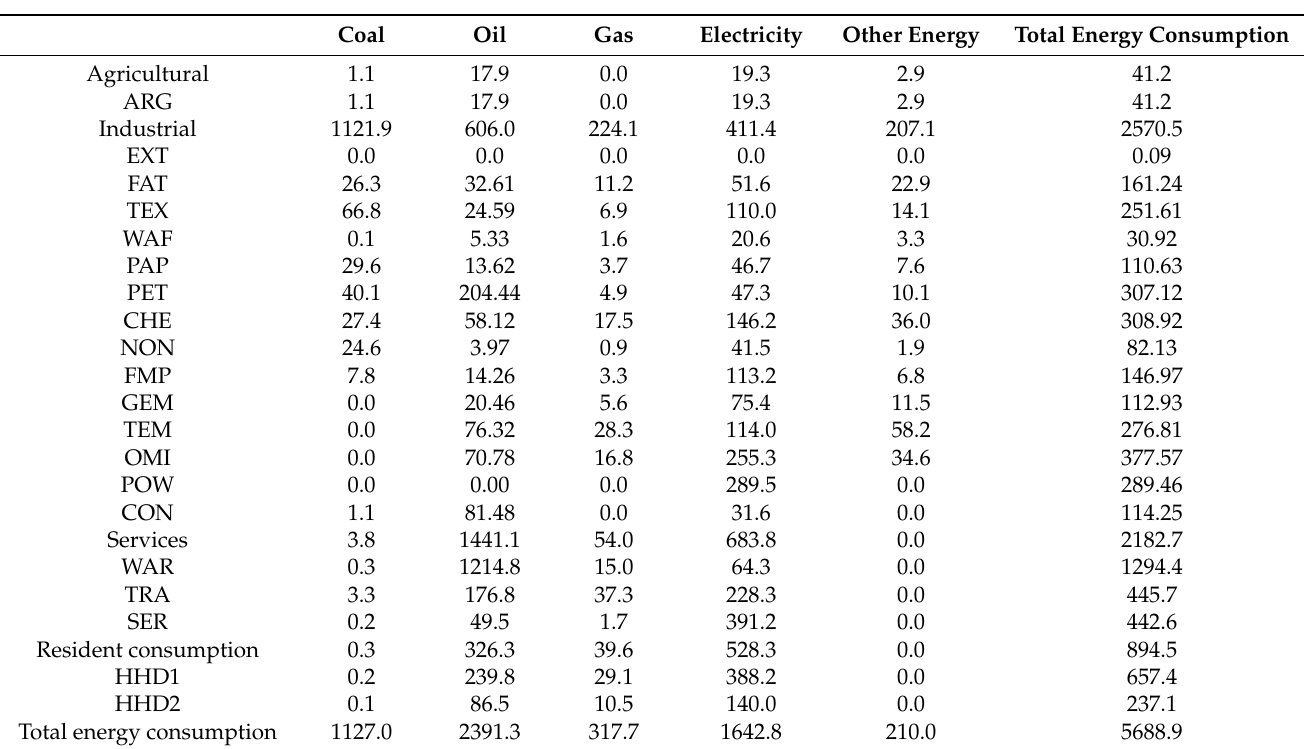
Table A6. Guangzhou Energy Balance Sheet 2015 (Unit: 10 4 tce) (data from the author’s survey and research).